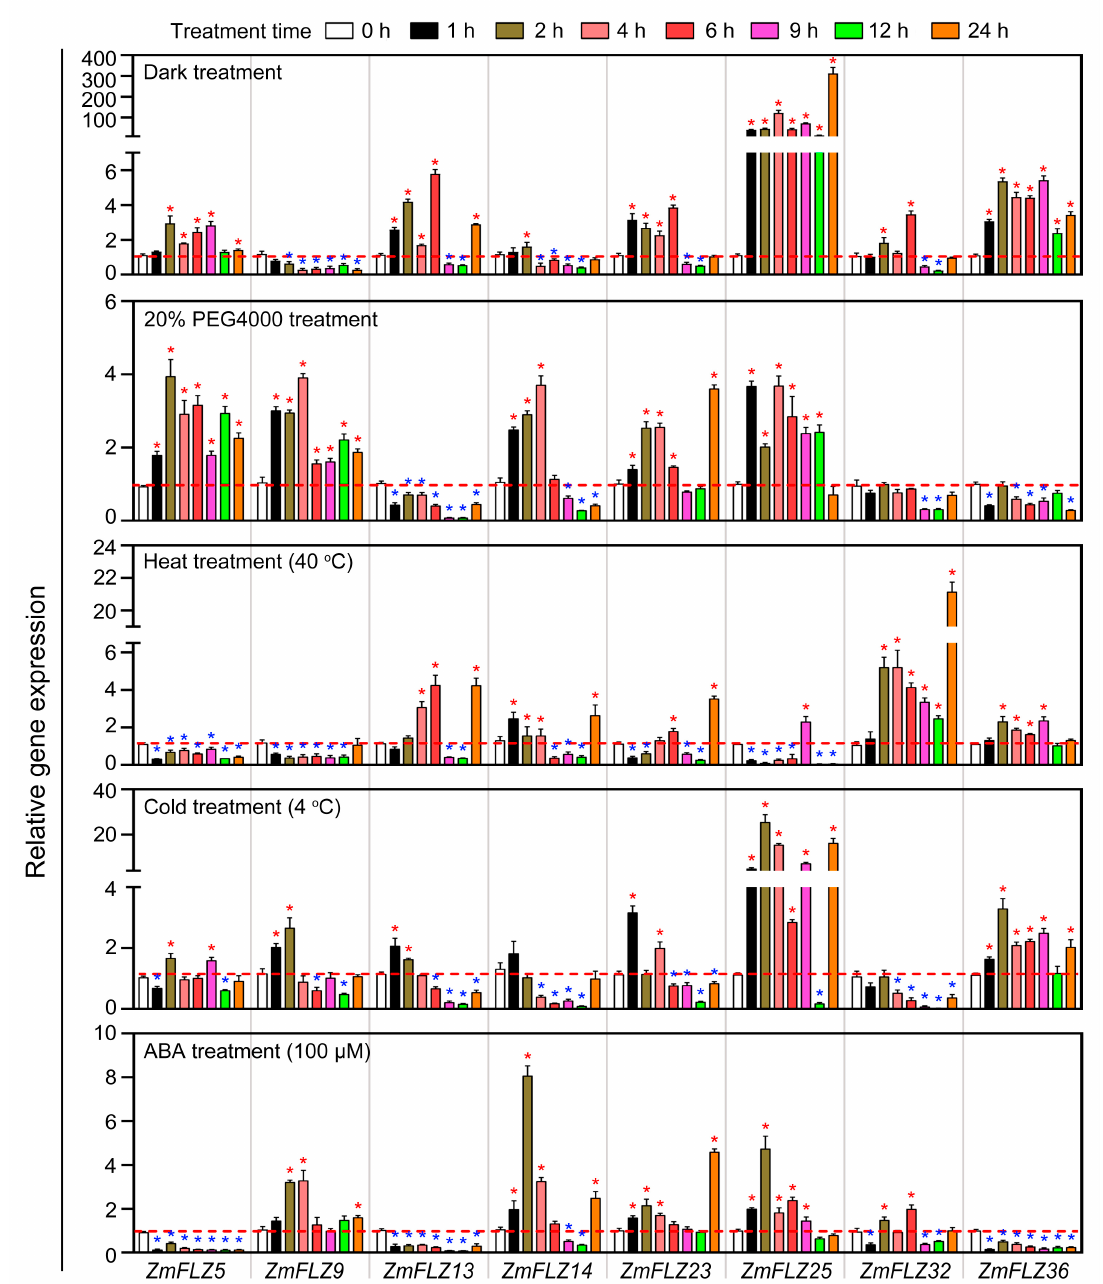
Figure 5. Expression pattern of ZmFLZs in response to stress treatments. Seedlings of B73 at V3 stage (three-leaf-stage, around 15 days after germination) were separately subjected to darkness, drought (20% PEG4000), heat (40 ◦ C), cold (4 ◦ C), and 100 µ M ABA treatments for 24 h. The leaves were harvested for gene expression analysis by qRT-PCR at 0 h, 1 h, 2 h, 4 h, 6 h, 9 h, 12 h, and 24 h, respectively. Seedlings grown under the normal conditions were harvested at the same time points and used as the controls. Relative gene expression levels of ZmFLZs were calculated as the ratio of “treatment” to “control” after being normalized against ZmActin . The mean ± SEM from three independent experiments were shown for each treatment. Multiple t -test was included to estimate the differences between the expression levels under stresses and untreated (0 h) conditions for each ZmFLZ gene. The red and blue asterisks indicated significantly enhanced and repressed expression under stresses, respectively ( p -value < 0.05).